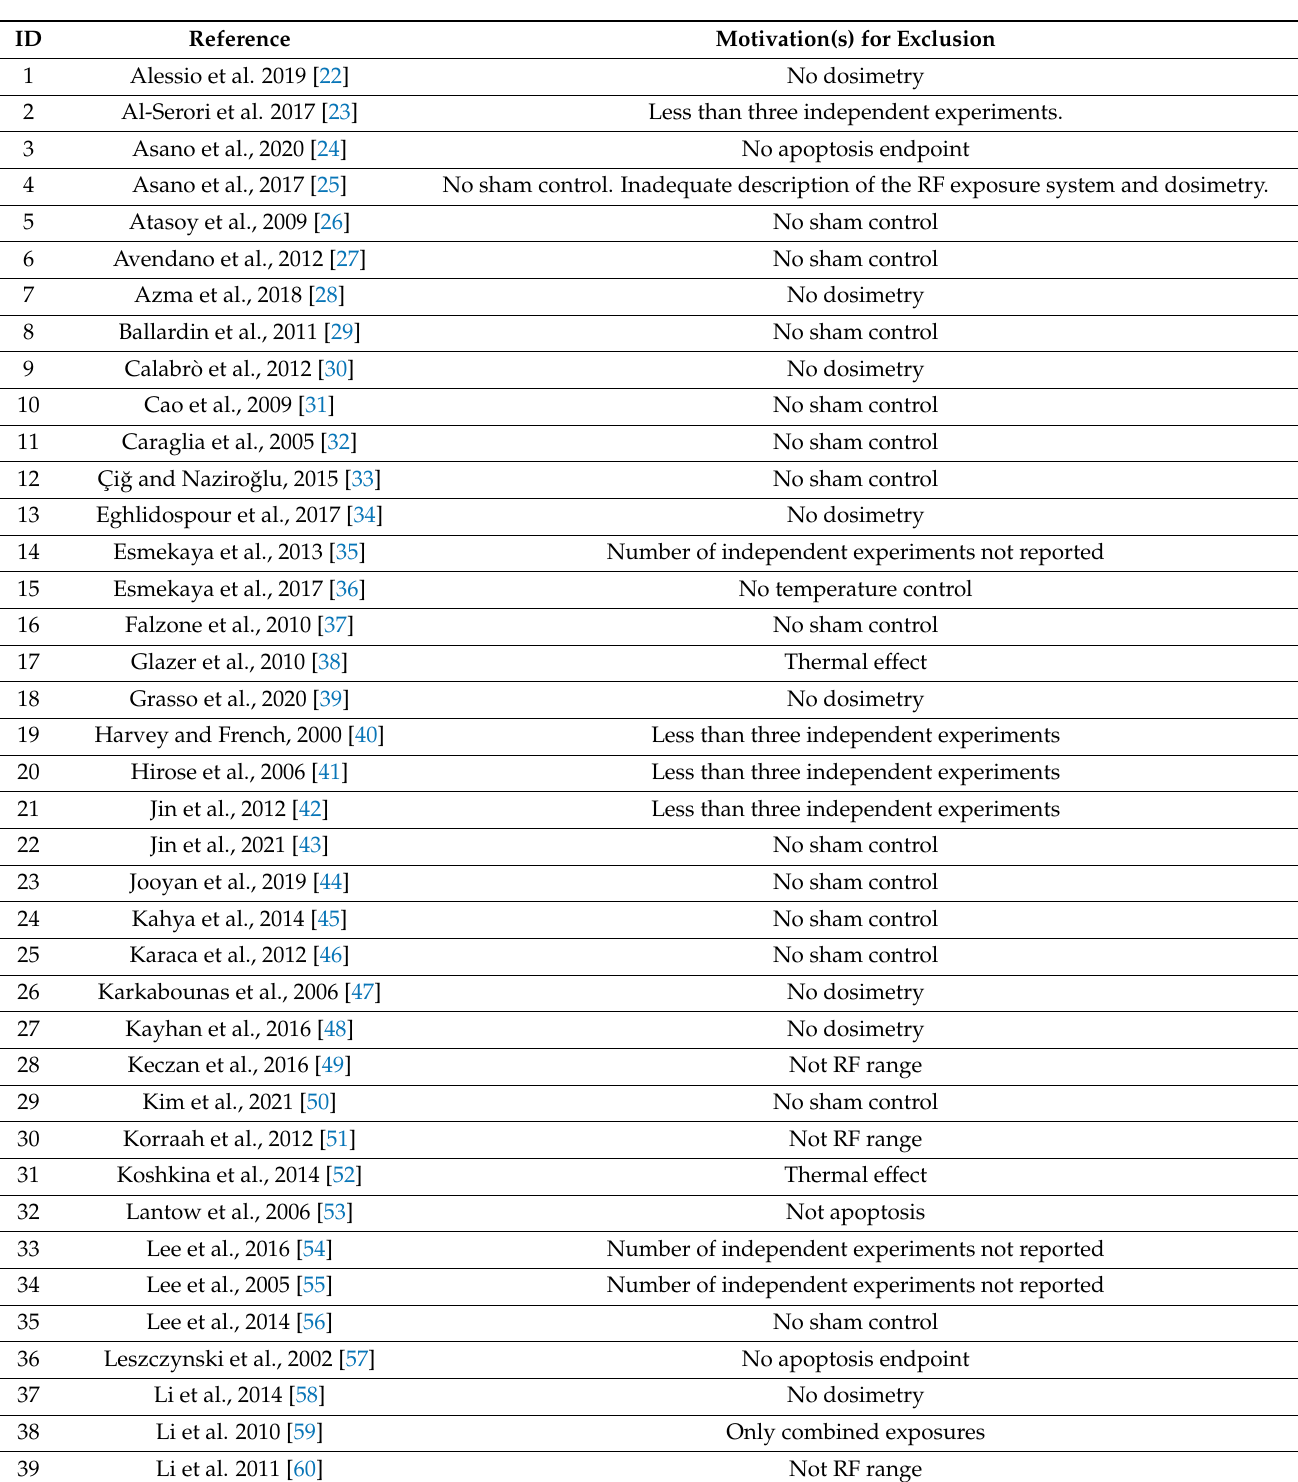
Table 2. Excluded papers with